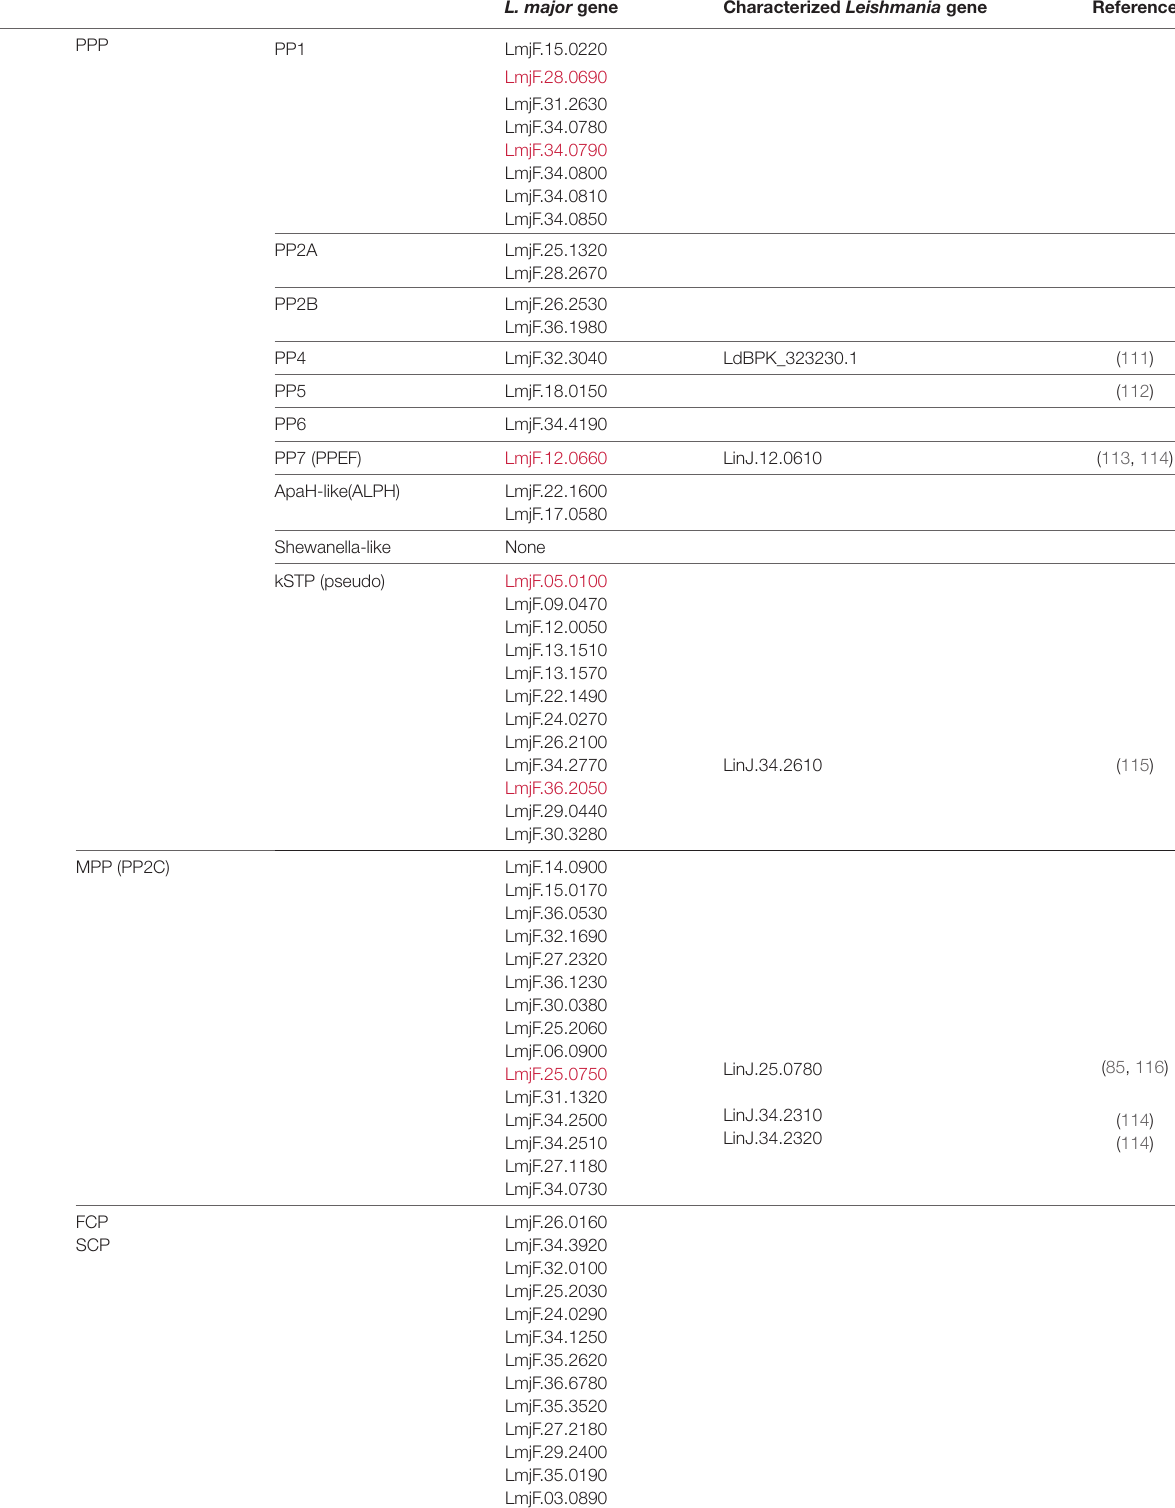
TABLe 1 | Serine threonine phosphatases of Leishmania major. a